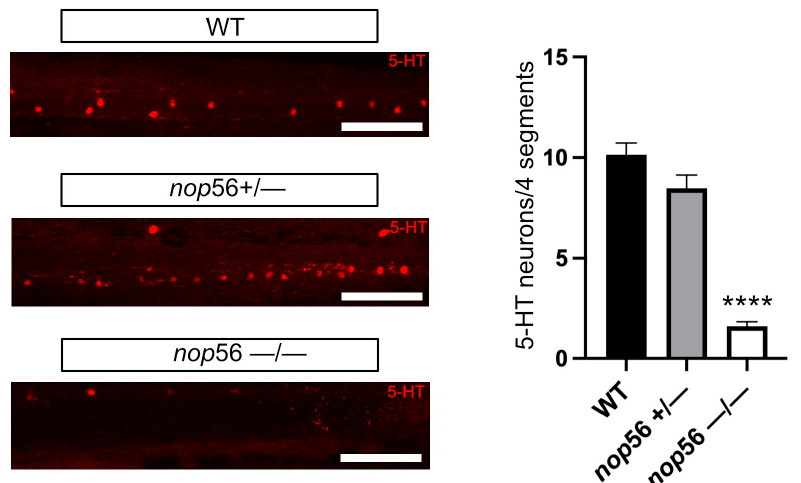
Figure 7. 5-HT immunofluorescence in 4 dpf zebrafish larvae revealed significant reduction in the number of 5-HT-ir spinal cord neurons in nop56 − / − animals. Scale bar: 150 μ m. Statistically significant data in the graphs are indicated with ****.